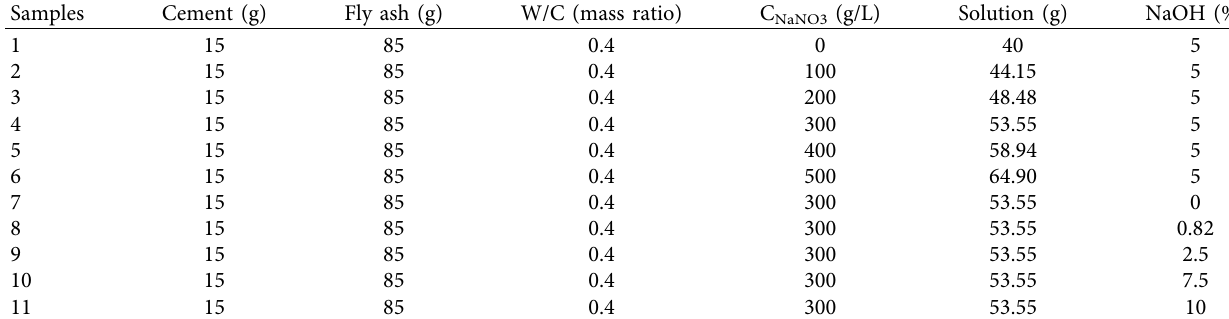
Table 1: Te mixture proportions of the